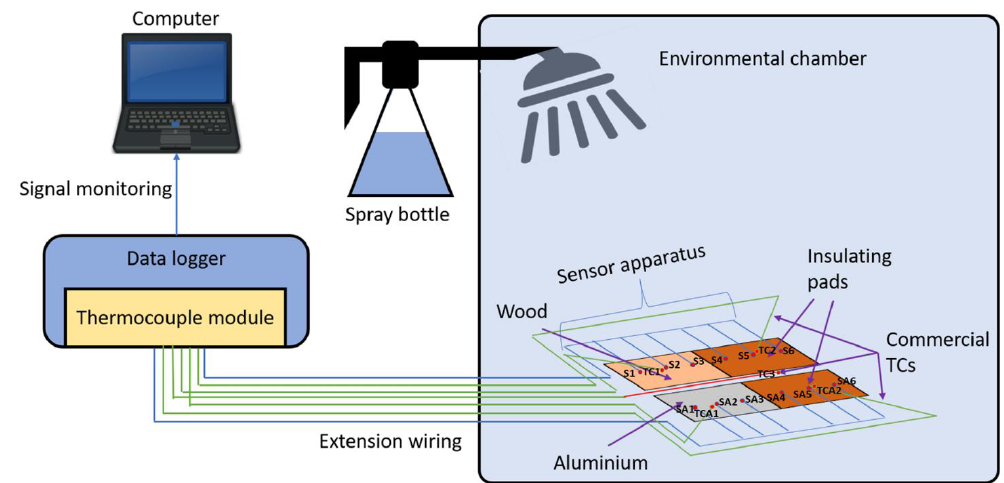
Figure 4. Experimental setup showing the position of the two sensors, each with 50% surface insulation. The upper port was used to extend the spray gun nozzle into the chamber interior during testing. The lower port was used to route the extension cables to the data logger (off-camera), which was directly connected to a laptop PC via USB.